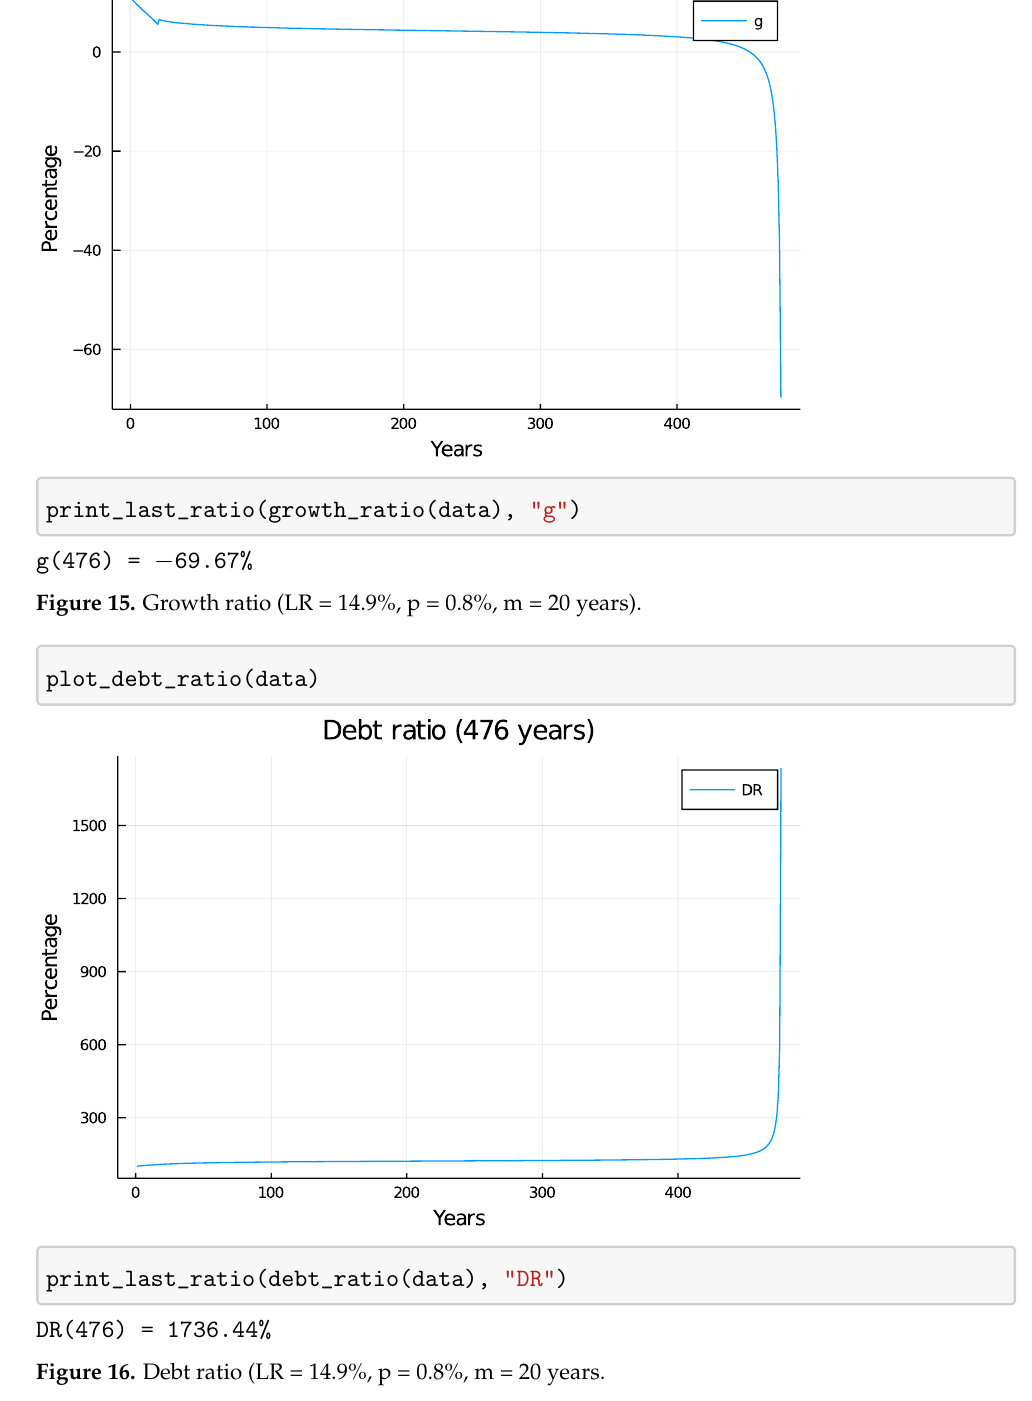
Figure 16. Debt ratio (LR = 14.9%, p = 0.8%, m = 20